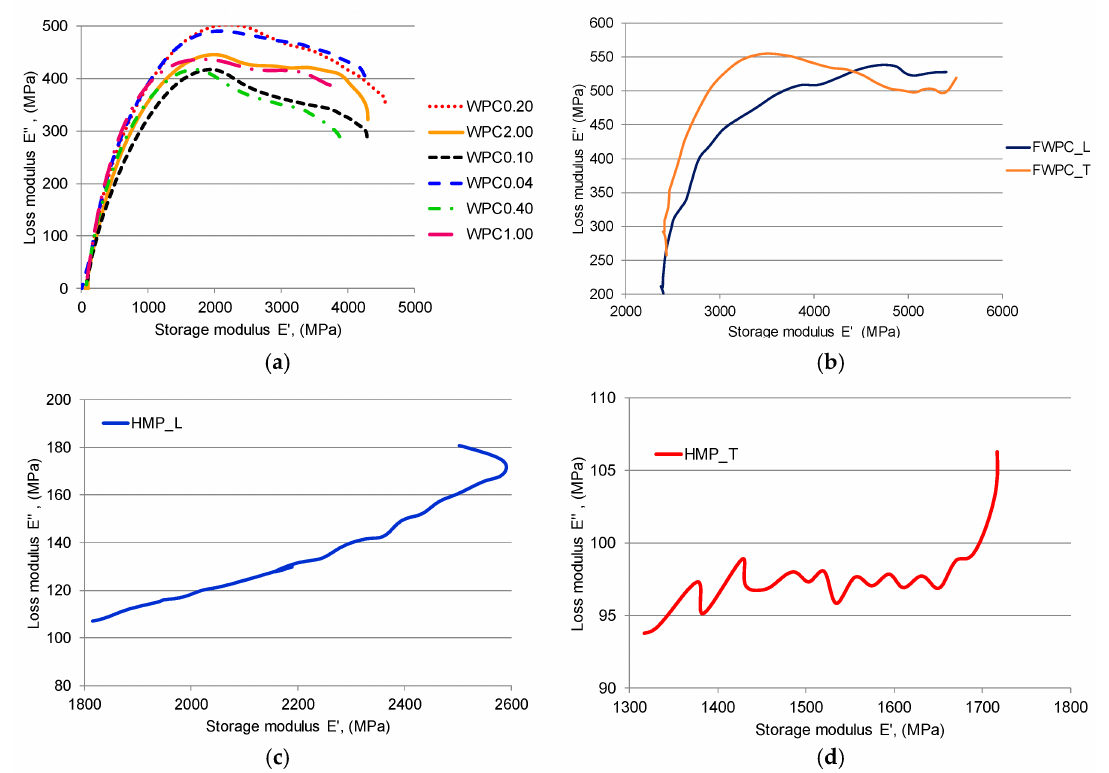
Figure 14. Cole–Cole plot: ( a ) WPC samples; ( b ) FWCP samples; ( c ) HMP_L sample; ( d ) HMP_T